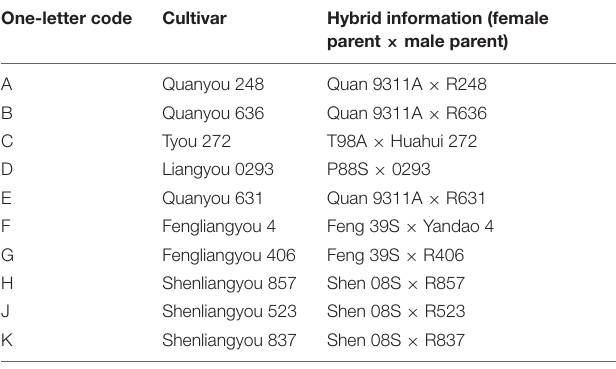
TABLE 1 | Rice cultivars implemented in the present